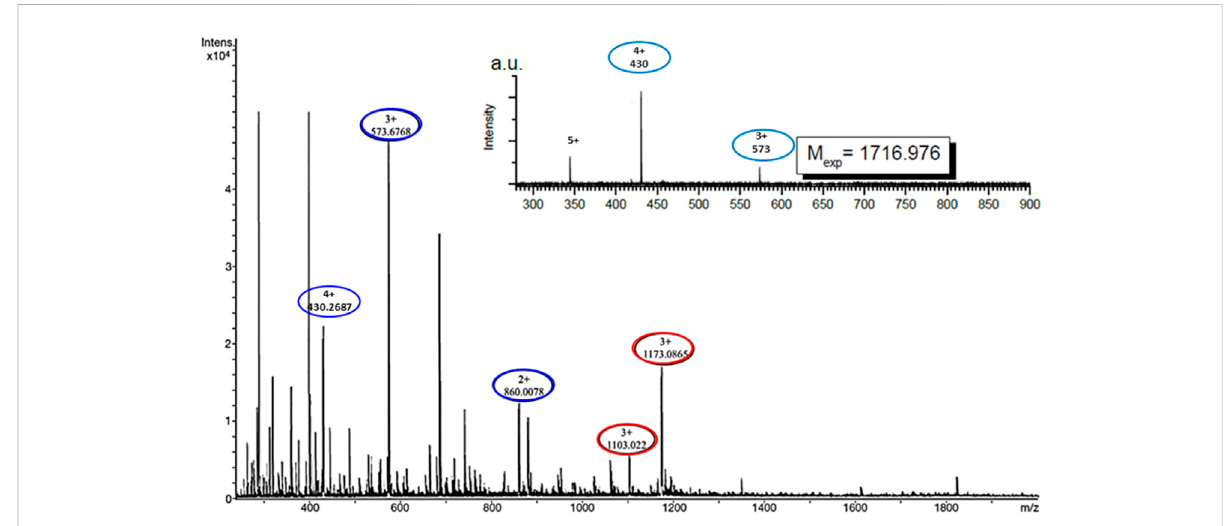
FIGURE 8 Electrospray ionisation mass spectra showing Lipid A binding to KDEON WK-11 represented by ion complex formation seen as single peaks expressing the molecular mass of both components. Red circles present at peaks 1103 and 1173 indicate the presence of the peptide-ion complex, proving the binding of KDEON WK-11. Blue circles at peaks 430, 573 and 860 (m/z), indicate the peptide alone (4+, 3+, 2 + charge state respectively of WK11), showing the signi fi cant difference between the two, in the presence and absence of ion complex formation. The inset indicates the spectrum of the peptide